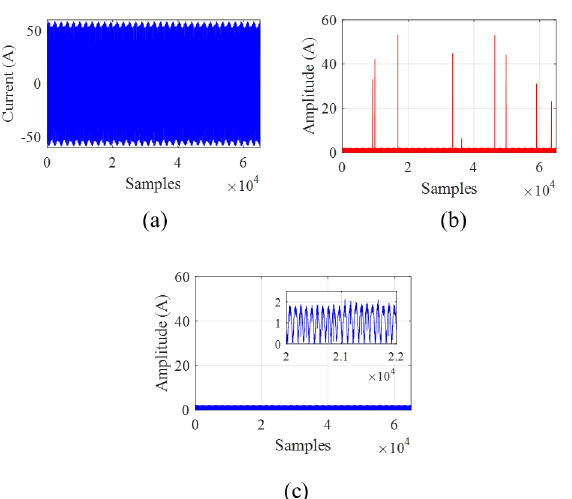
Figure 4. ( a ) The acquired stator current, ( b ) the result of moving subtraction filter for the detection of discontinuities, and ( c ) after the correction of discontinuous